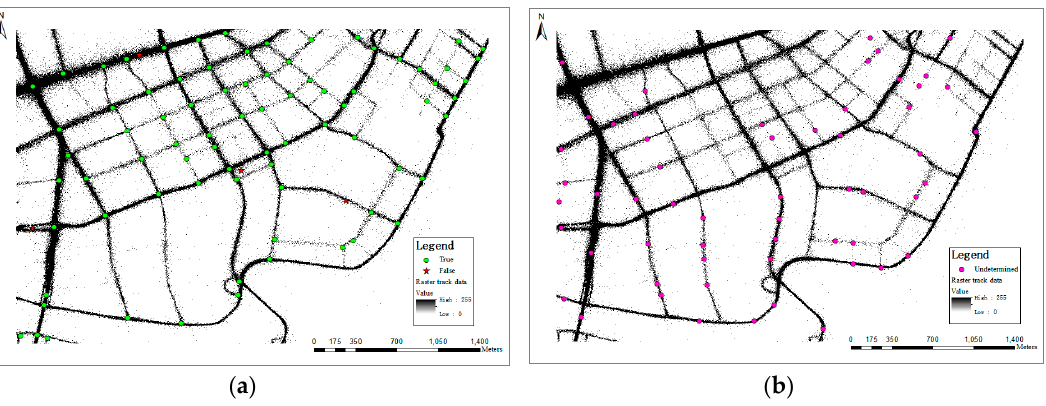
Figure 10. The fusion results (overlaying 2.5 m raster track data): ( a ) True and false results; ( b ) undetermined results.